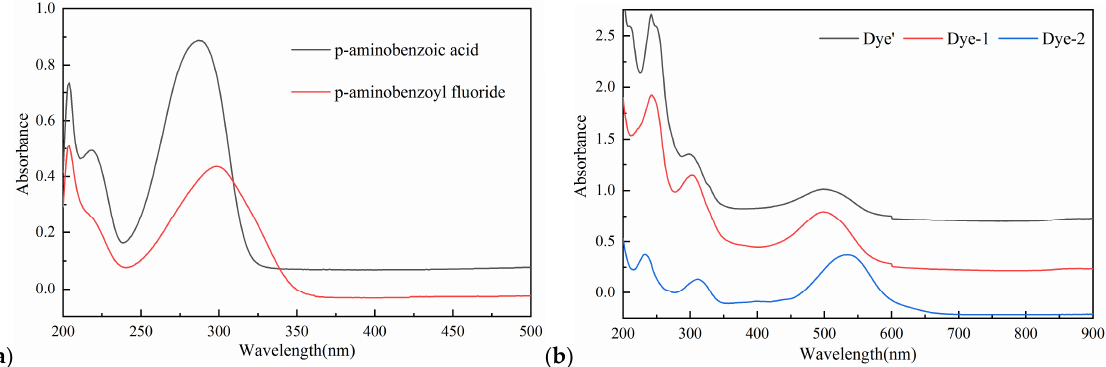
Figure 1. ( a ) UV absorption spectra of PABF and PABA; ( b ) UV absorption spectra of Dye’/Dye-